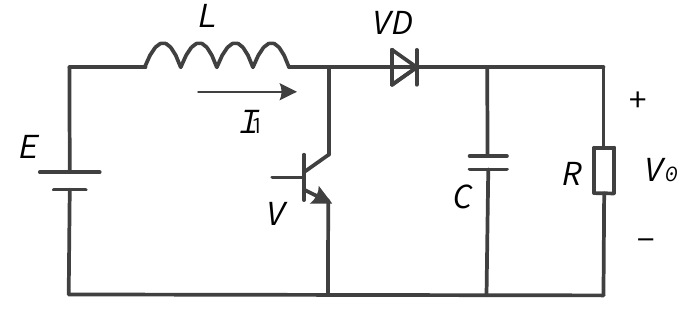
Figure 7. Boost chopper circuit.